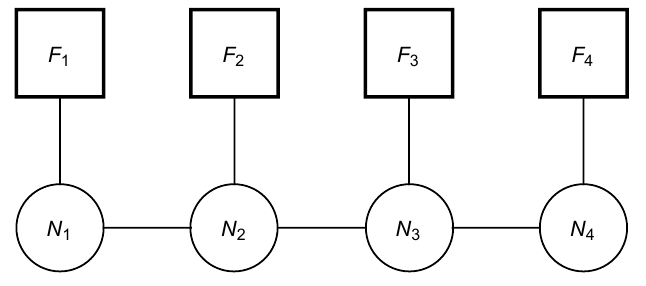
Figure 5. The quiver corresponding to the generic (cid:12)eld theory studied